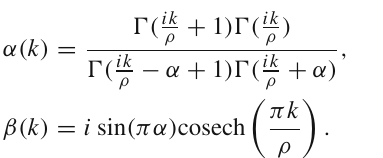
where α( k ) and β( k ) are the Bogoliubov coefficients,